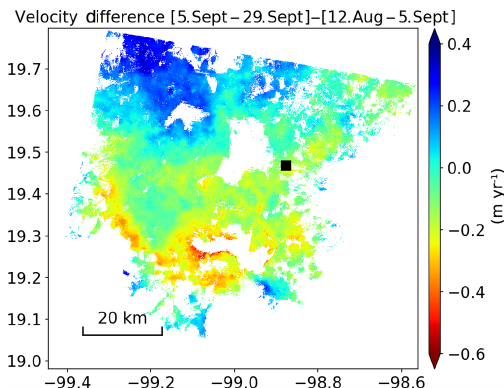
Figure 4. Subsidence velocity difference obtained by subtracting the 24d subsidence vertical velocity field calculated from Fig. 3b prior to the M w 8.2 Tehuantepec and the M w 7.1 Puebla, Septem- ber 2017 earthquakes vertical velocity field calculated from Fig.